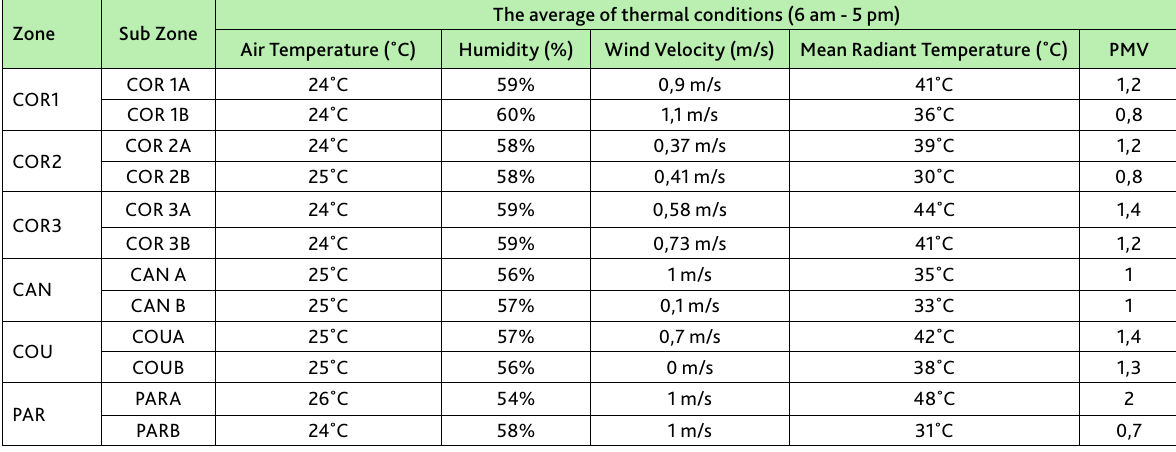
Table 4. The average thermal condition in different zone